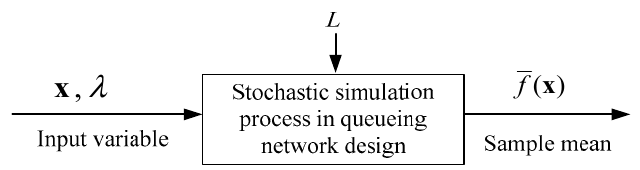
Figure 4. Input output relationship in queueing network design.